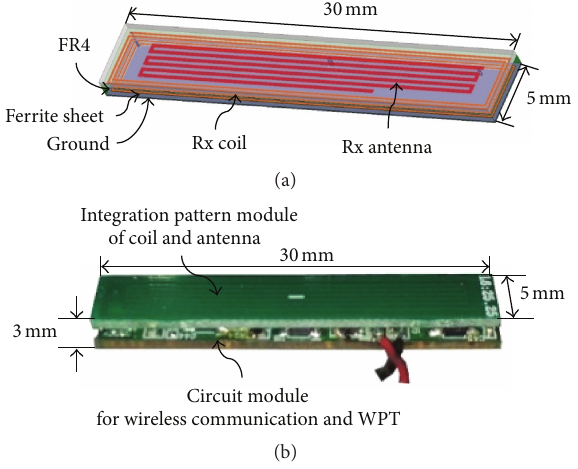
Figure 3: The proposed resonant coil and MICS antenna: (a) perspective view and (b) fabricated prototype of the implant device.